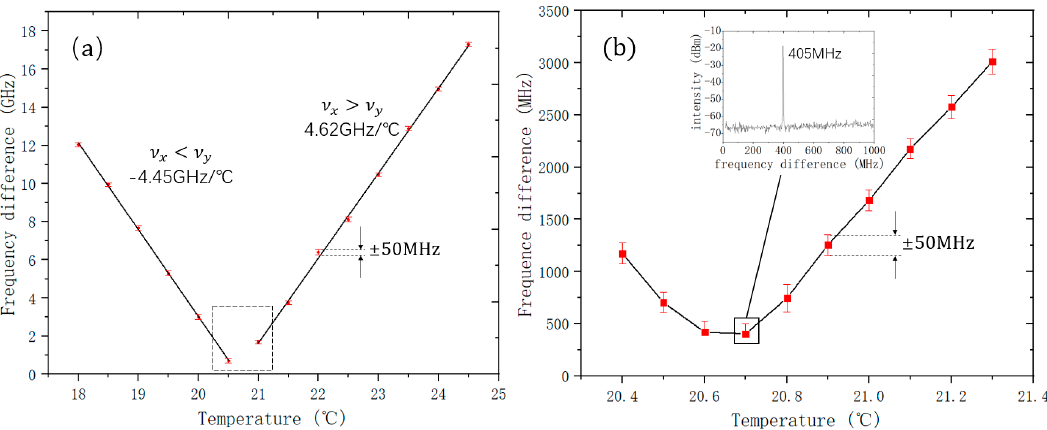
Figure 3. The relationship between the frequency di ff erence and temperature of 18 ◦ C–24.5 ◦ C ( a ) and 20.4 ◦ C–21.3 ◦ C ( b ). Data was measured by an F-P scanning interferometer. The minimum value of the frequency di ff erence (in the insert of ( b )) at 20.7 ◦ C was measured by a fiber input photon